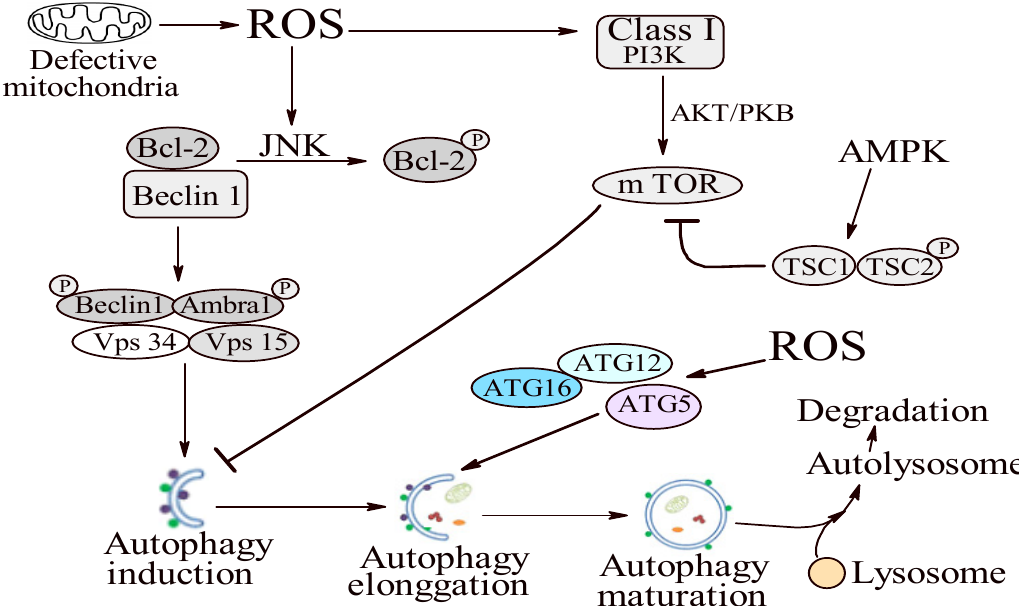
Figure 1. Schematic representation of the possible mechanism of autophagy regulation in the periodontitis context. Autophagy can be modulated by ROS via four different pathways: (1) Atg12– Atg5 complex activation, promoting autophagy elongation; (2) ROS-dependent JNK induced Bcl-2 phosphorylation triggering Beclin 1 dissociation and autophagy induction; (3) PI3K-AKT pathway initiation triggering the activation of mTOR, which, in turn, acts as an autophagy induction inhibitor; and (4) the AMPK-dependent TORC1 activity inhibition leading to autophagy activation. Adapted from Liu C. et al. [51].